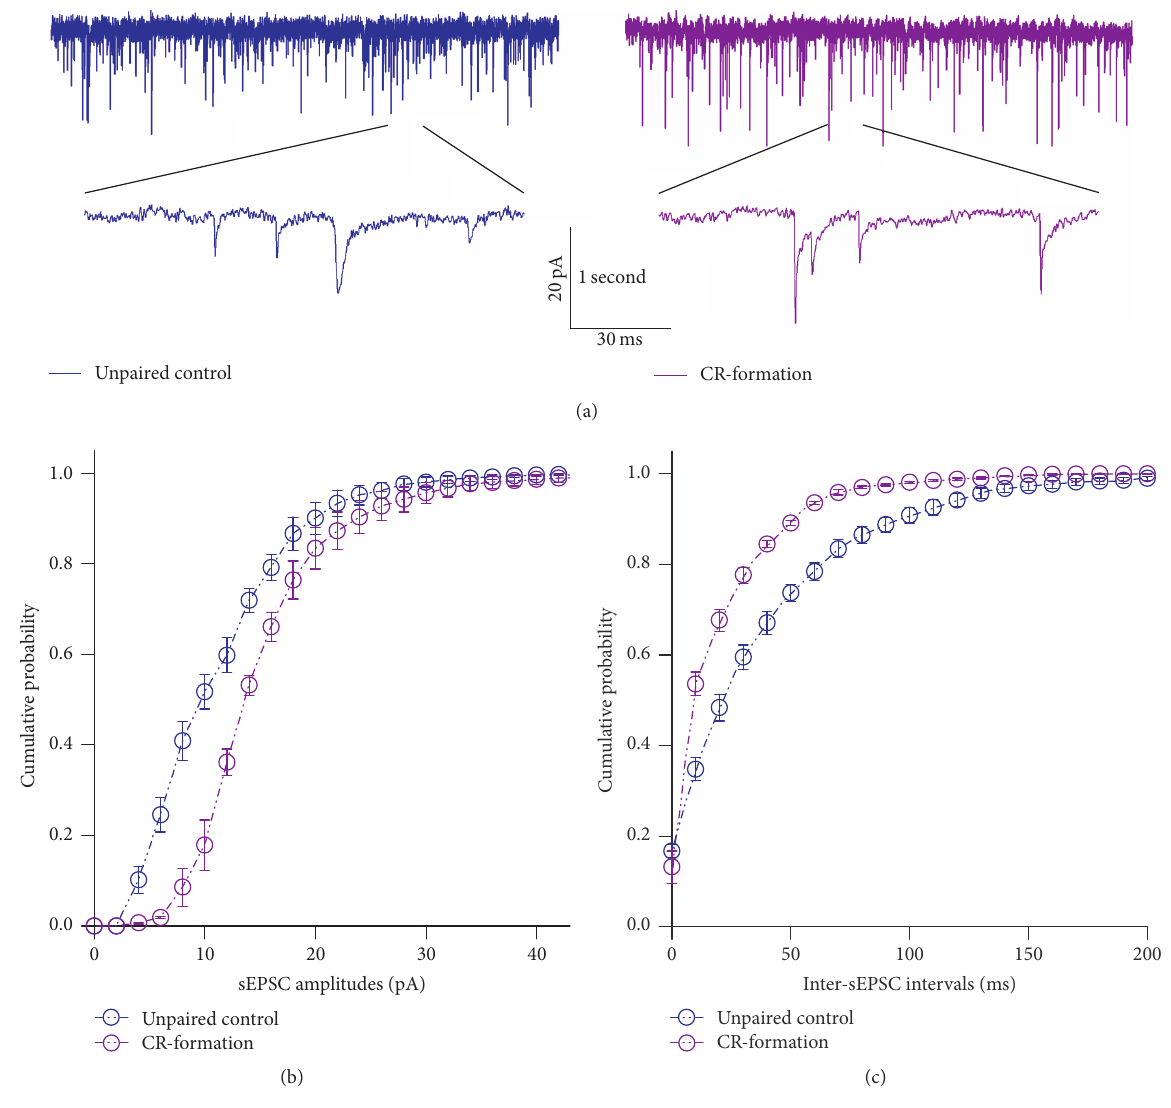
Figure 3: Excitatory synaptic transmission on barrel cortical pyramidal neurons increases after pairing WS and OS. Spontaneous excitatory postsynaptic currents (sEPSCs) were recorded on the pyramidal neurons in cortical slices under voltage-clamp (holding potential at − 70 mV) in presence of 10 𝜇 M bicuculline. (a) shows sEPSCs recorded on the neurons in control (dark-blue trace in left panel) and CR-formation (dark-red in right). Bottom traces are the expanded waveforms selected from top traces. Calibration bars are 20 pA, 1 second (top) and 30ms (bottom). (b) shows cumulative probability versus sEPSC amplitudes from control (dark-blue symbols, 𝑛 = 16 ) and CR-formation neurons (dark-red symbols, 𝑛 = 15 ). (c) illustrates cumulative probability versus inter-sEPSC intervals from control (dark-blue symbols, 𝑛 = 16 ) and CR-formation (dark-red symbols, 𝑛 = 15